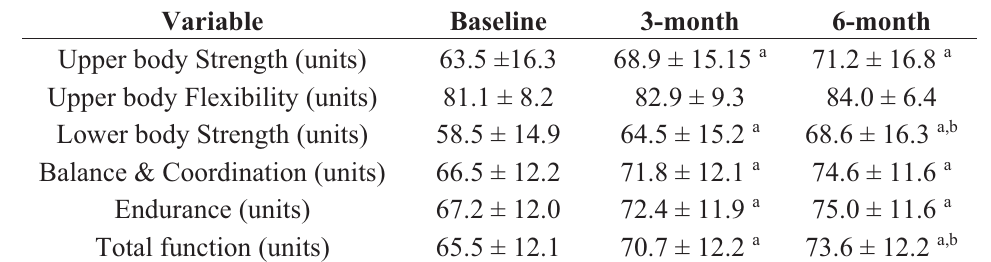
Table 4. Comparison of Continuous Scale-Physical Functional Performance* ( N = 27).